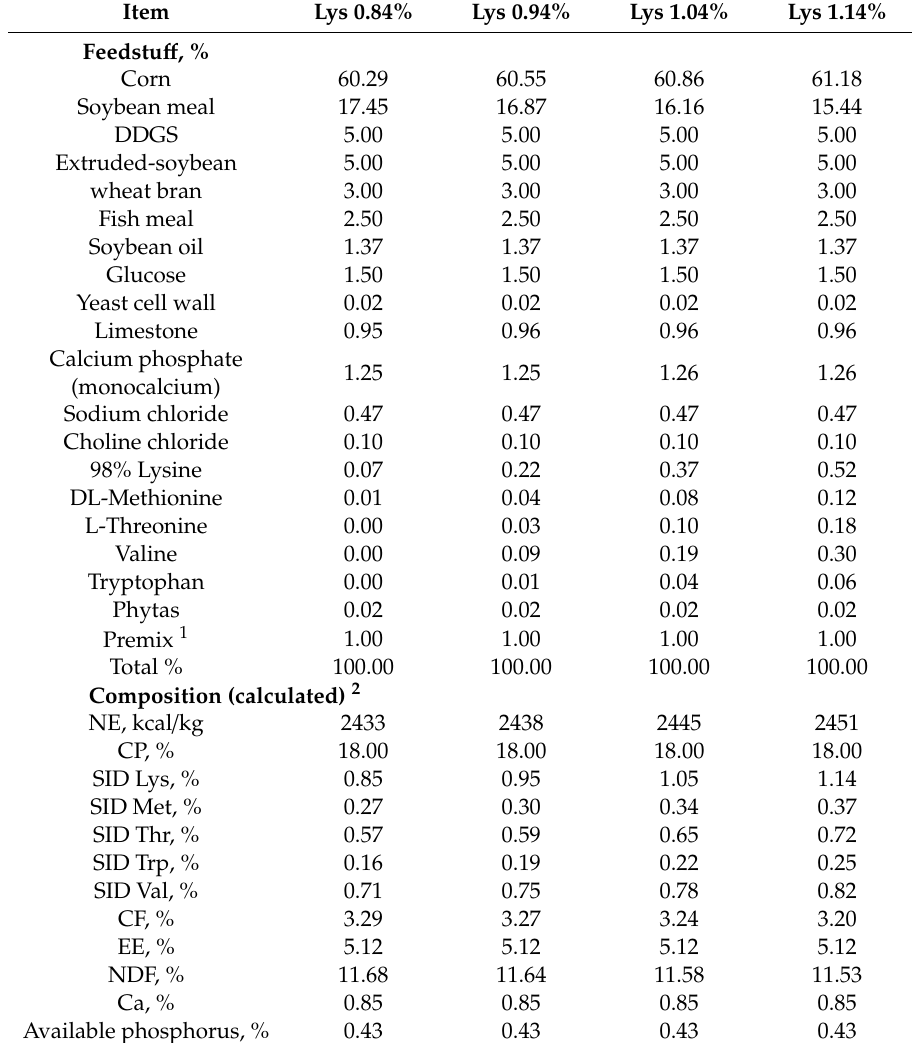
Table 1. Ingredients and nutrient compositions of the experimental